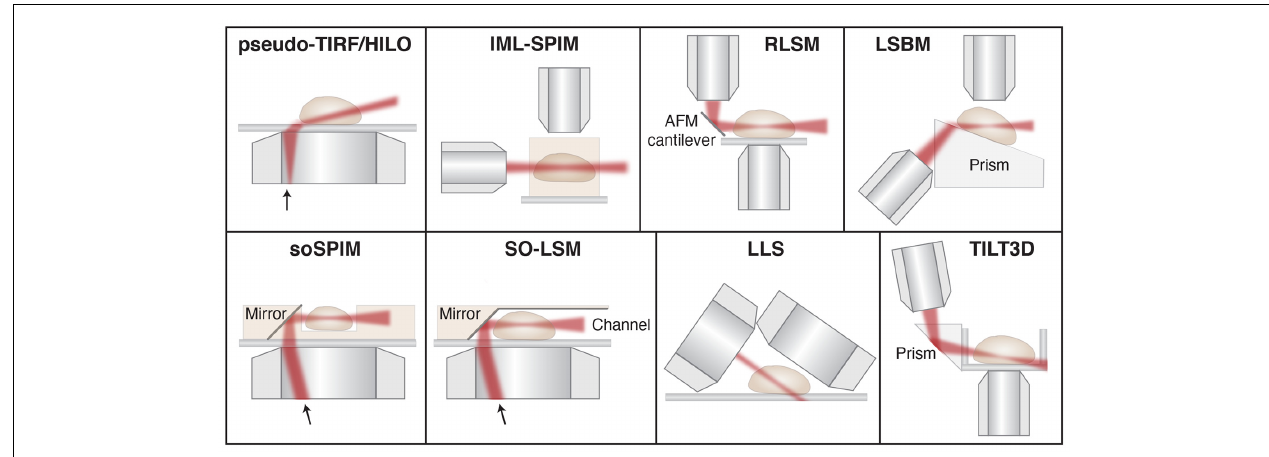
FIGURE 6 | Schematic showing different light sheet approaches developed for improved single-molecule tracking and super-resolution imaging. Pseudo- TIRF/HILO, highly inclined and laminated optical sheet (Tokunaga et al., 2008); IML-SPIM, individual molecule localization with selective-plane illumination microscopy (Cella Zanacchi et al., 2011); RLSM, reflected light sheet microscopy (Gebhardt et al., 2013); LSBM, light-sheet Bayesian microscopy (Hu et al., 2013); soSPIM, single-objective SPIM (Galland et al., 2015); SO-LSM, single-objective light-sheet microscopy (Meddens et al., 2016); LLS, lattice light-sheet (Chen B.-C. et al., 2014); TILT3D, tilted light sheet microscopy with 3D PSFs (Gustavsson et al., 2018a). Illustrations are not to scale. Figure adapted with permission from Gustavsson et al. (2018b) © The Optical